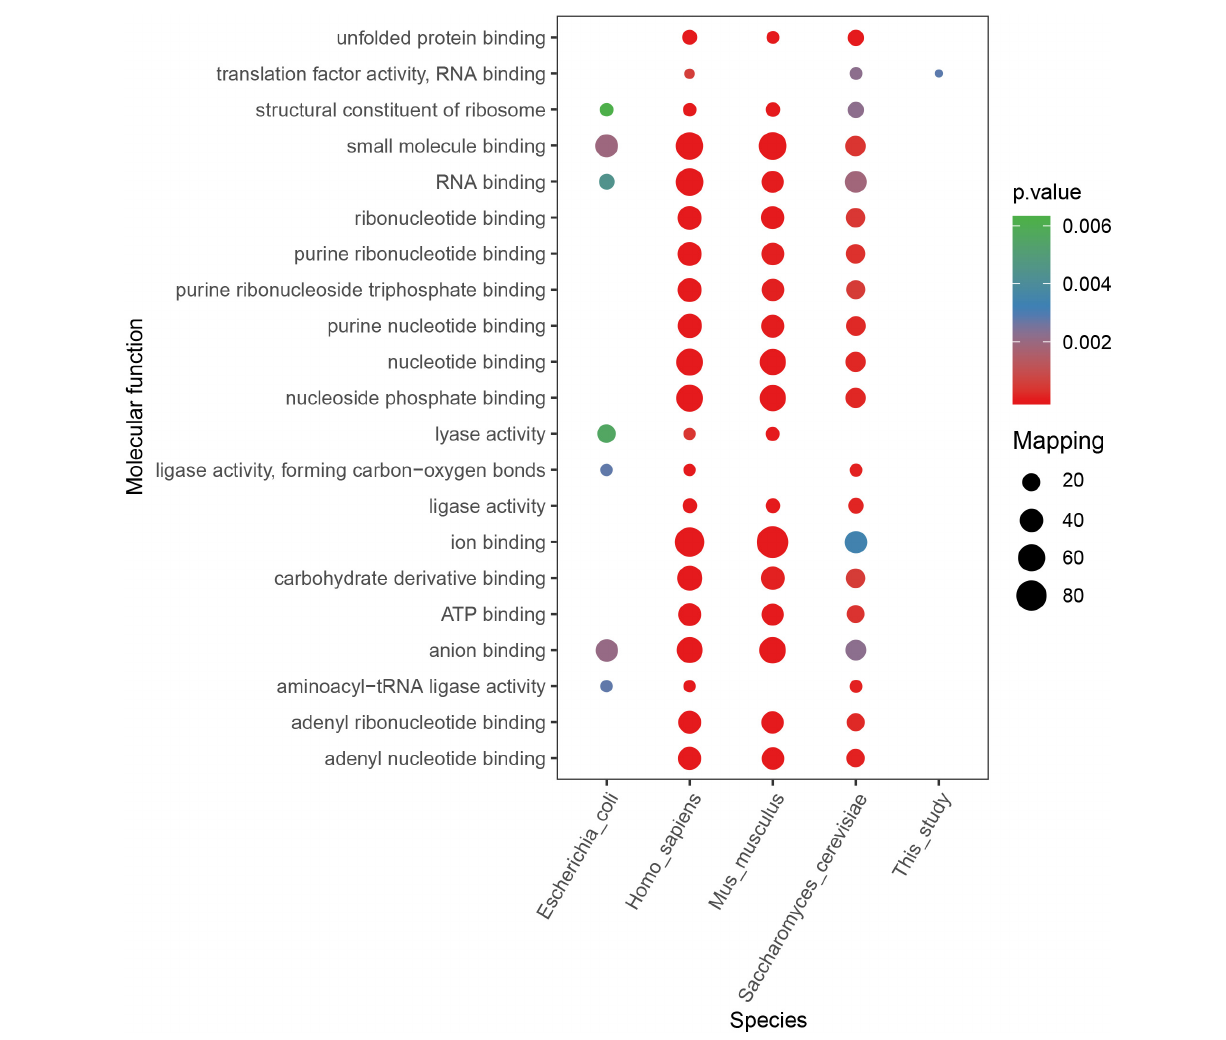
FIGURE 9 | Molecular function enrichment analysis of succinylated proteins with KsuD motif among five organisms ( Escherichia coli , Homo sapiens , Mus musculus , Saccharomyces cerevisiae , and Staphylococcus epidermidis